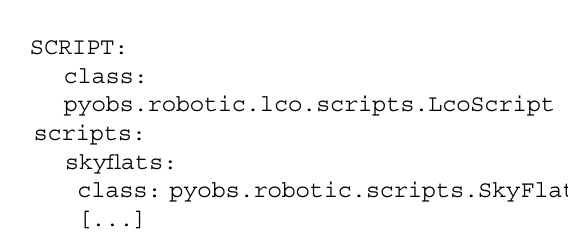
Frontiers in Astronomy and Space Sciences |